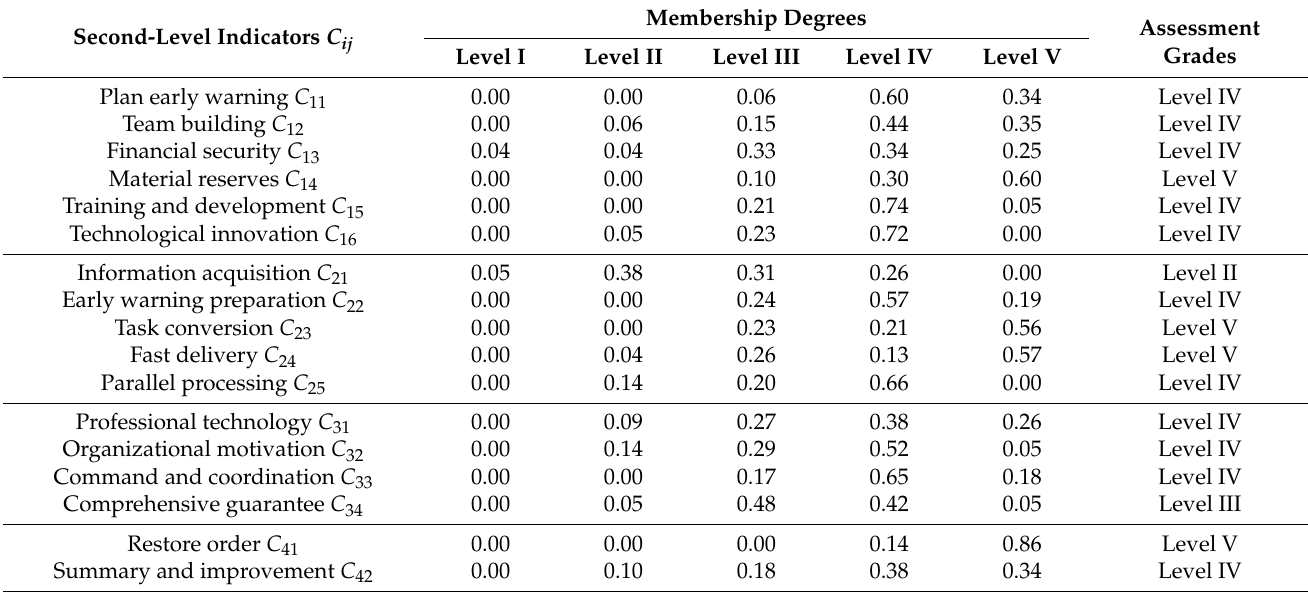
Table A13. Assessment information matrixes of second-level indicators.